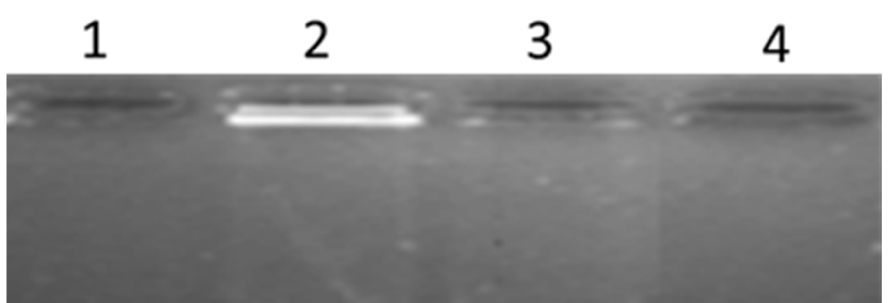
Figure 12. Agarose gel electrophoresis of TiO 2 scaffolds.